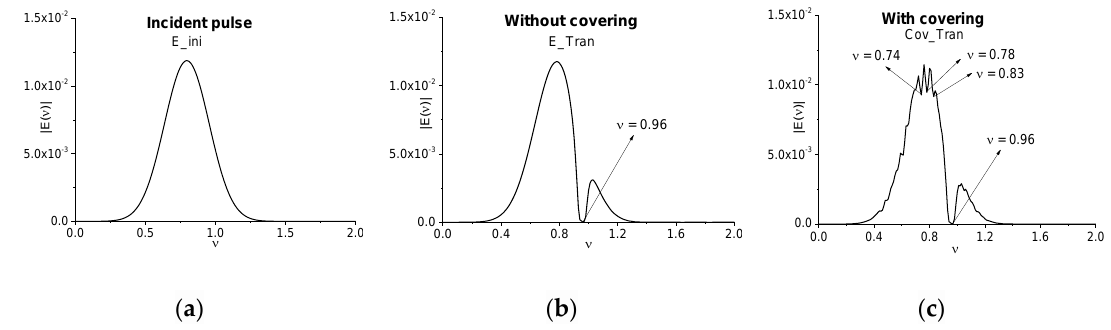
Figure 6. Fourier spectra of the incident pulse E_ini ( a ) and pulses E_Tran ( b ), Cov_Tran ( c ) transmitted through the medium without and with covering, correspondingly. The time interval of measurement is equal to t = [0, 100], the spectral resolution is equal to ∆ν = 0.01